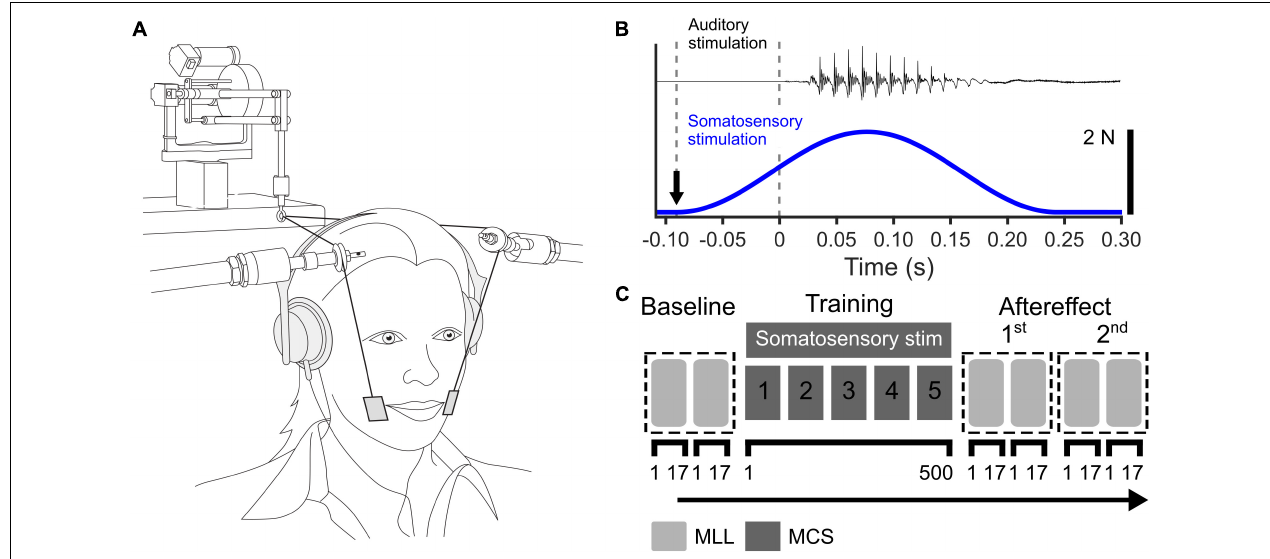
FIGURE 1 | (A) Experimental setup for somatosensory stimulation using facial skin deformation, reproduced from Ito et al. (2009). (B) Time course of auditory stimulus (top) and applied force during somatosensory stimulation (bottom). The black arrow represents the onset of somatosensory stimulation. (C) Experimental procedure in the auditory-somatosensory perceptual adaptation test. MLL represents the maximum likelihood procedure and MCS represents the perceptual test based on the method of constant